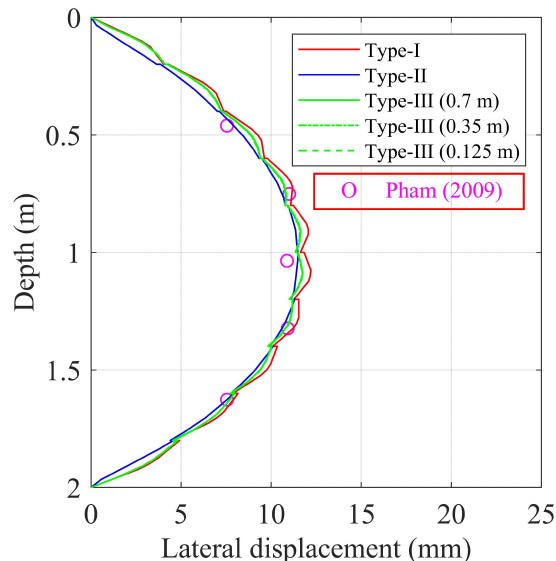
Figure 8. Effect of compaction procedures on lateral displacement of SGC mass for case of p = 1000 kPa and q = 44